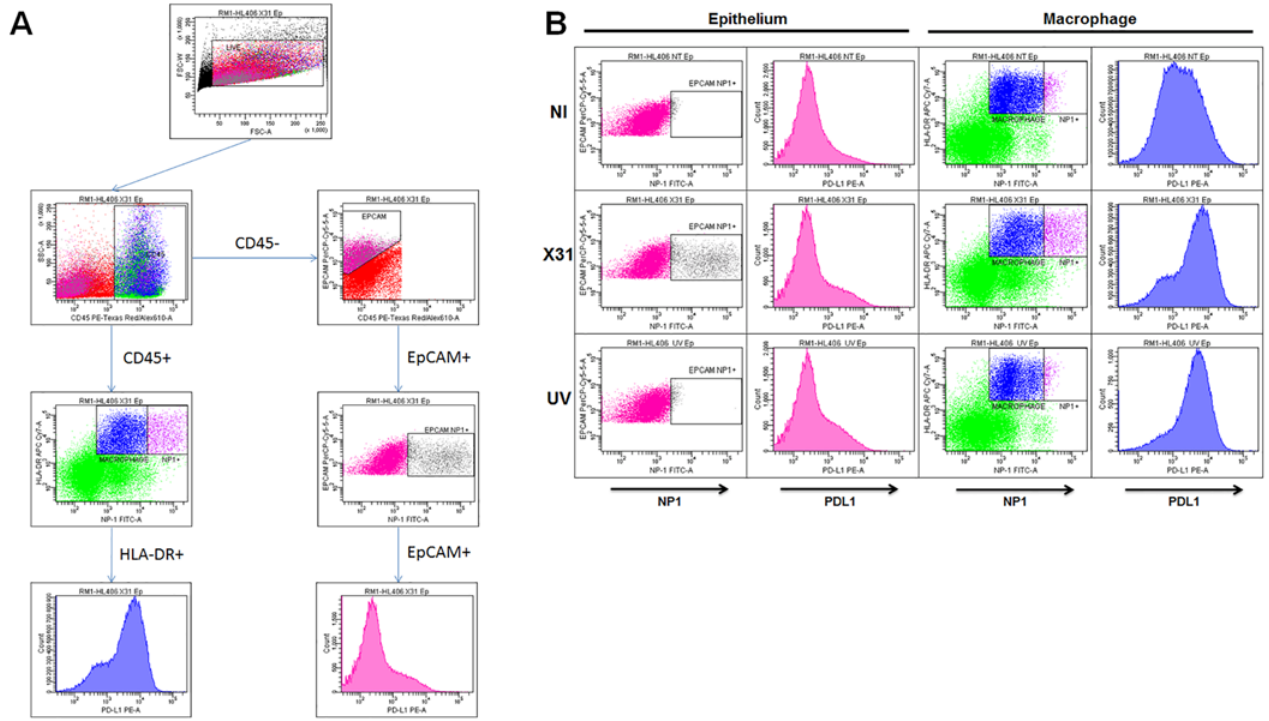
Fig 1. Ex vivo infection of human lung explants. After resting explanted lung tissue overnight, 1 x 10 6 pfu/ml H3N2 X31 influenza virus or a UV-irradiated aliquot of virus (UVX31) was added for 2 h. After washing, media was replaced and the tissue was incubated for a further 22 h followed by collagenase digestion and flow cytometry analysis A) Gating strategy for identification of CD45+HLADR+ macrophages and CD45-EpCAM+ epithelial cells expressing viral NP1 and PDL1 from lung tissue. B) FACS plots demonstrating increases in influenza infection (NP1) with corresponding increases in PDL1 expression. Plots are representative of nine independent experiments.